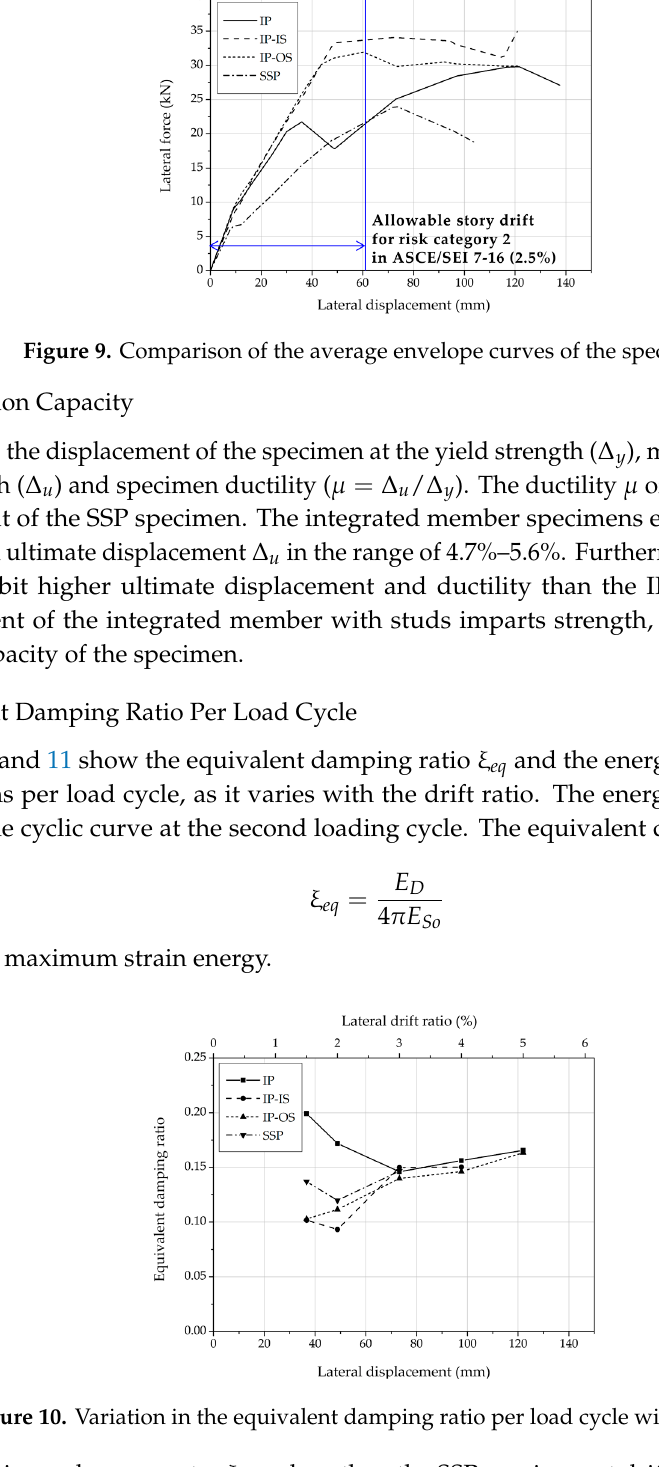
Figure 9. Comparison of the average envelope curves of the specimens.